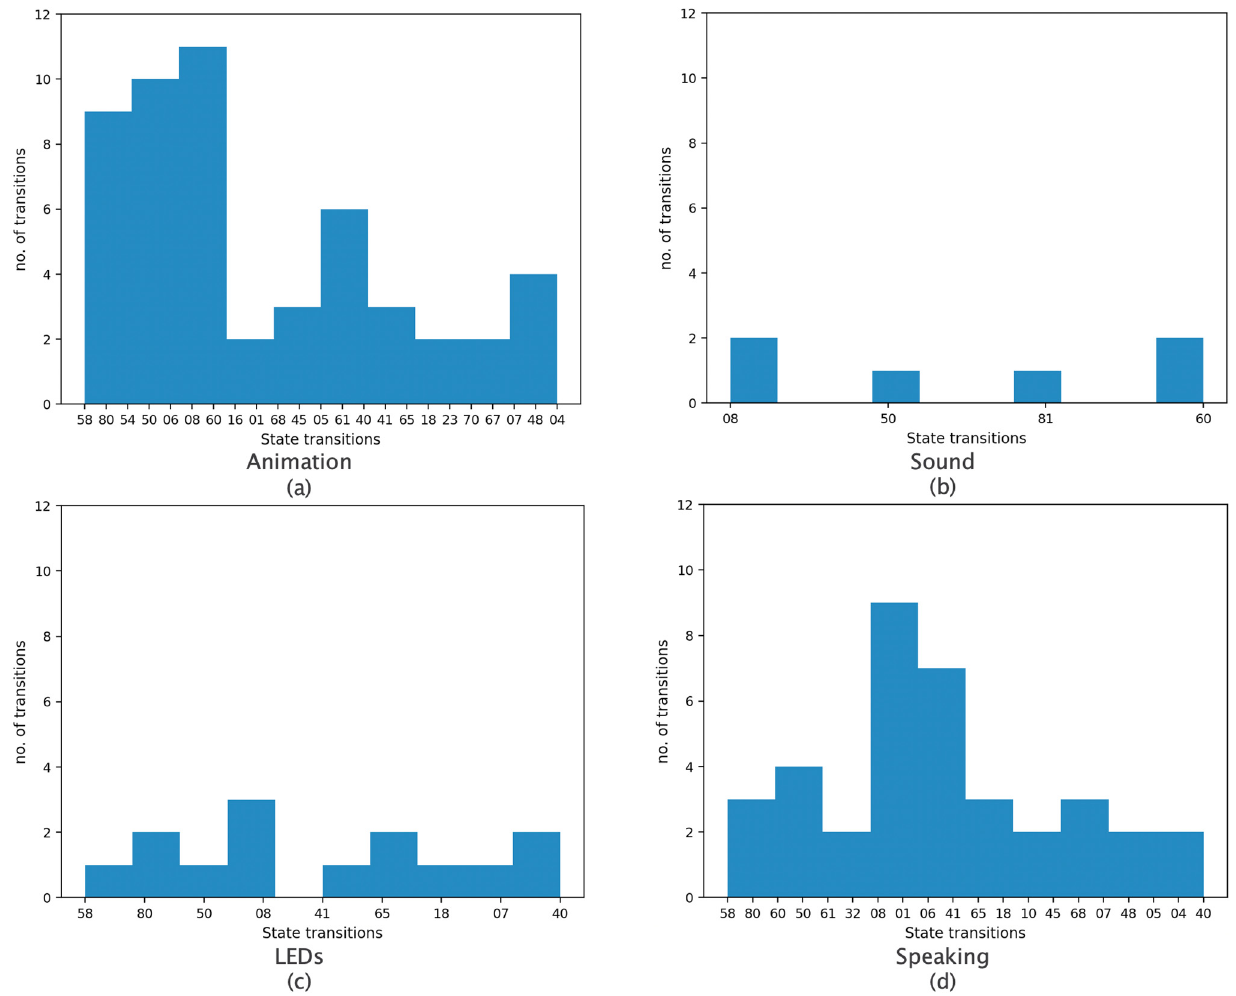
Figure 9. Histograms of all children’s state transitions for four robot modalities, namely ( a ) Animation, ( b ) Sound ( c ) LEDs and ( d ) Speaking by the robot.